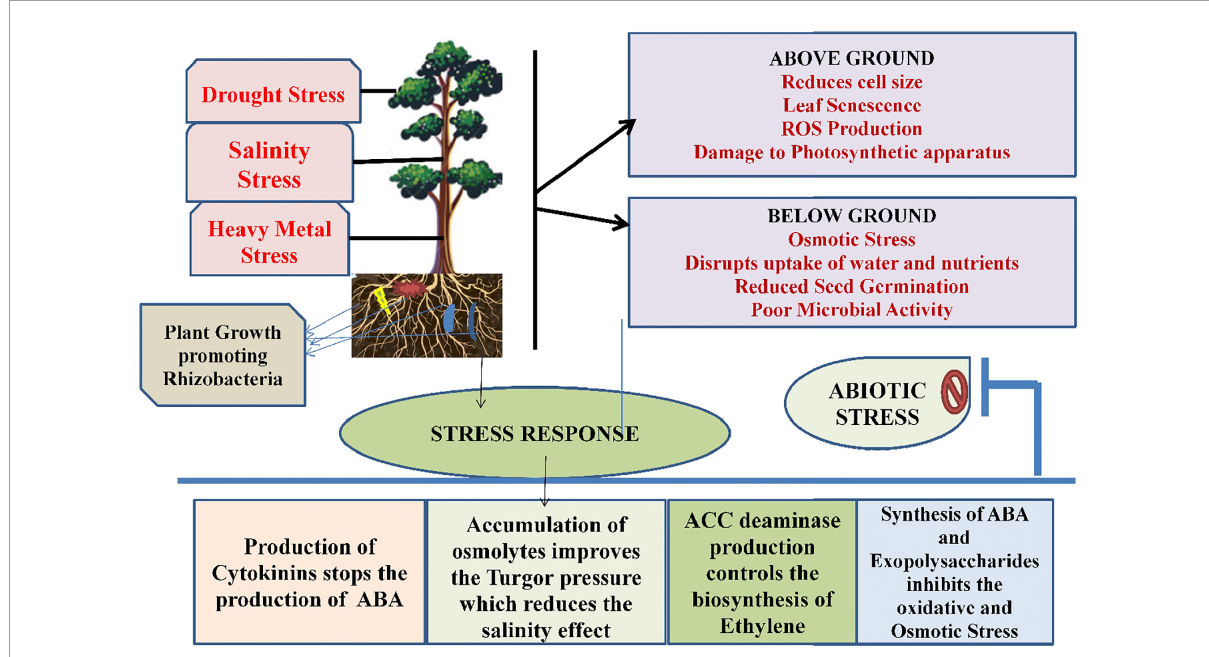
FIGURE3 The role of plant growth-promoting rhizobacteria in association with plants under abiotic